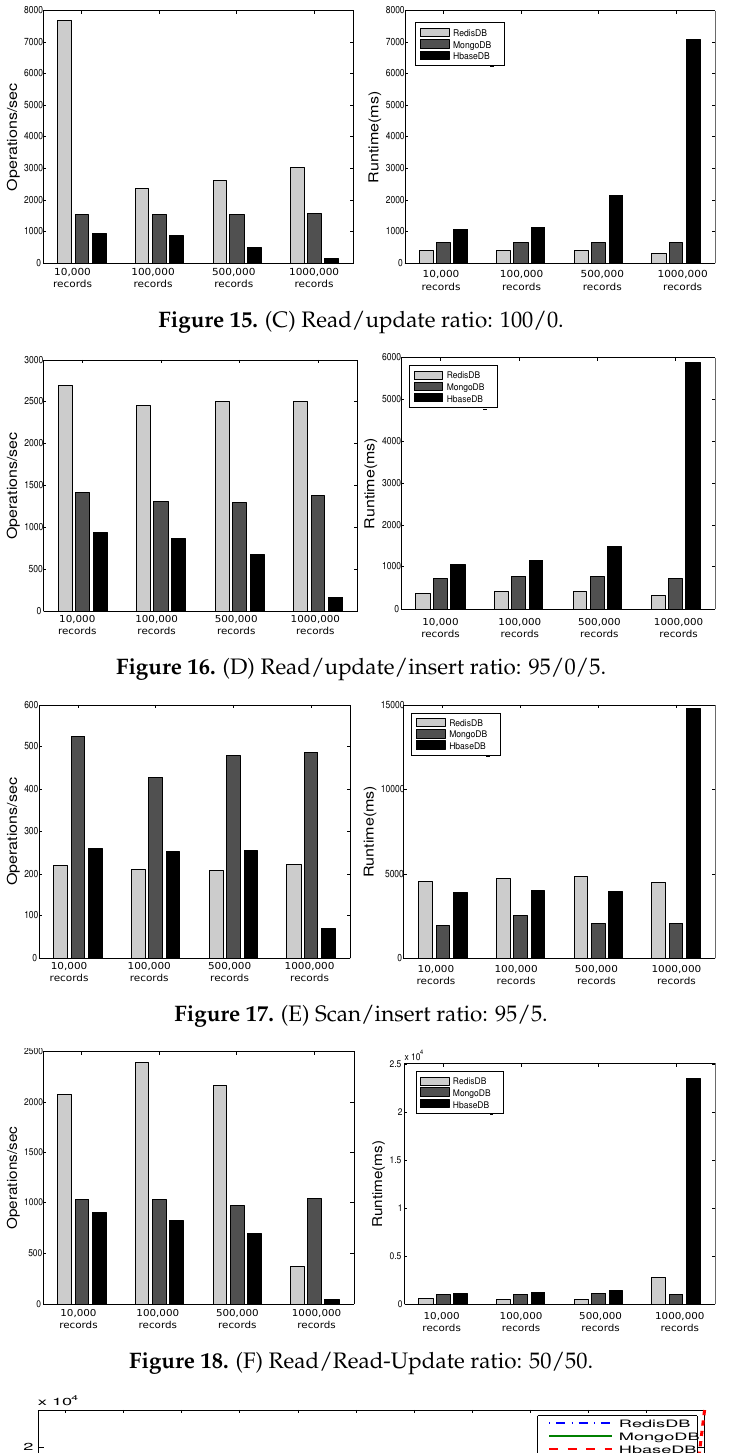
Figure 15. (C) Read/update ratio: 100/0.